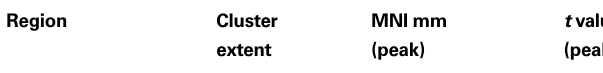
Table 2 | Top clusters from group statistical maps, all